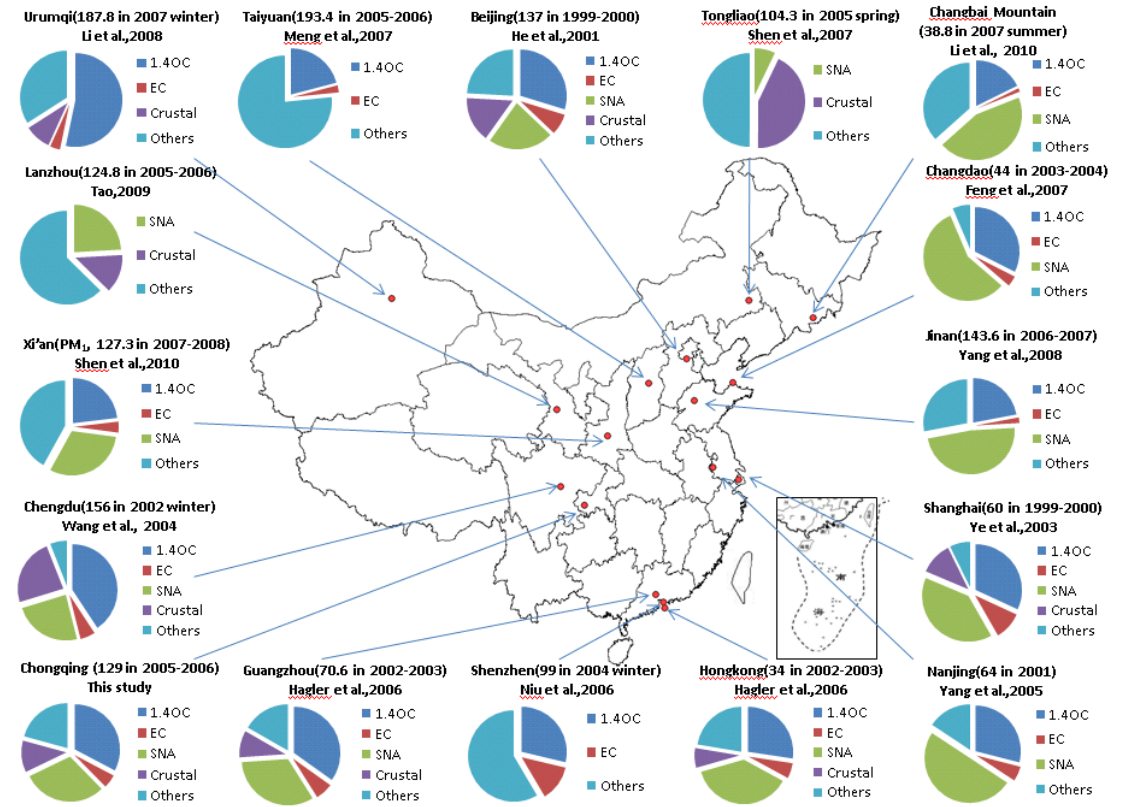
Fig. 3. PM 2 . 5 (except PM 1 . 0 in Xi’an) speciation at urban and rural locations in China. The rural sites are Changbai Mountain, Tongliao, and Changdao. Averaging periods, average PM 2 . 5 mass (µgm − 3 ) , and references are indicated. A coefficient of 1.4 to convert OC to OM was adopted for all the sites for fair comparison. For some sites without elements data, crustal material was not reconstructed. In Taiyuan and Shenzhen, only OC and EC were analyzed, while in Lanzhou carbonaceous species were not